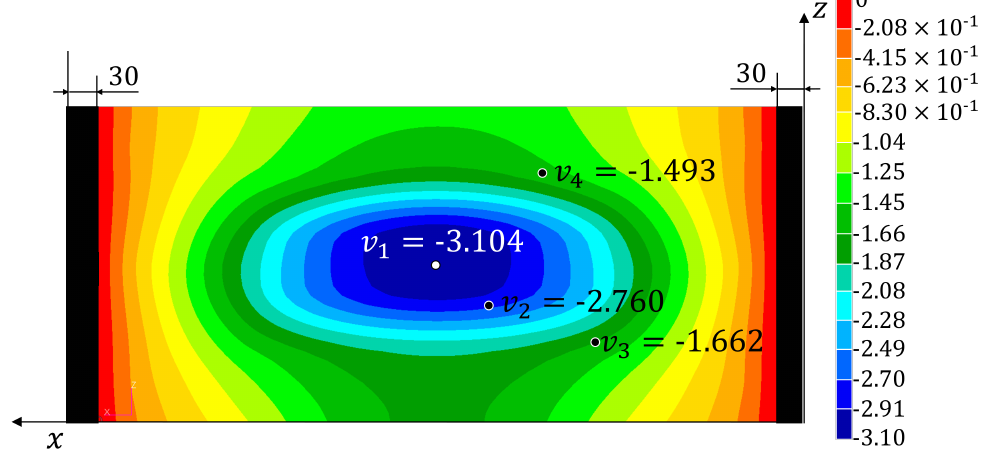
Figure 12. Test 3—Transverse displacement contour for the Modal Method ( 1,2,3,8,12 ) with all dimensions in